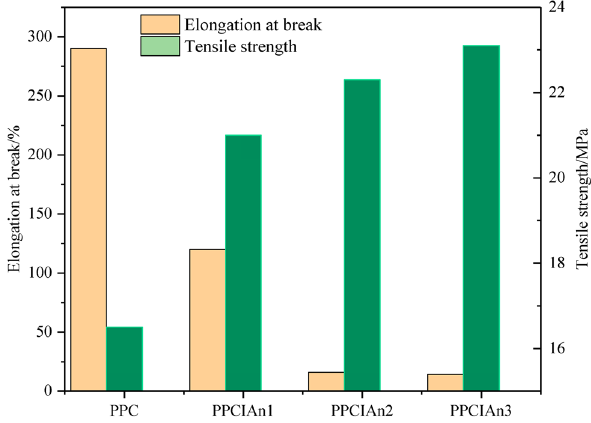
Figure 3: Thermogravimetric analysis curves of PPC and PPCIAns. PPC1 – PPC3 refers to the soluble fraction of the corresponding copolymer.